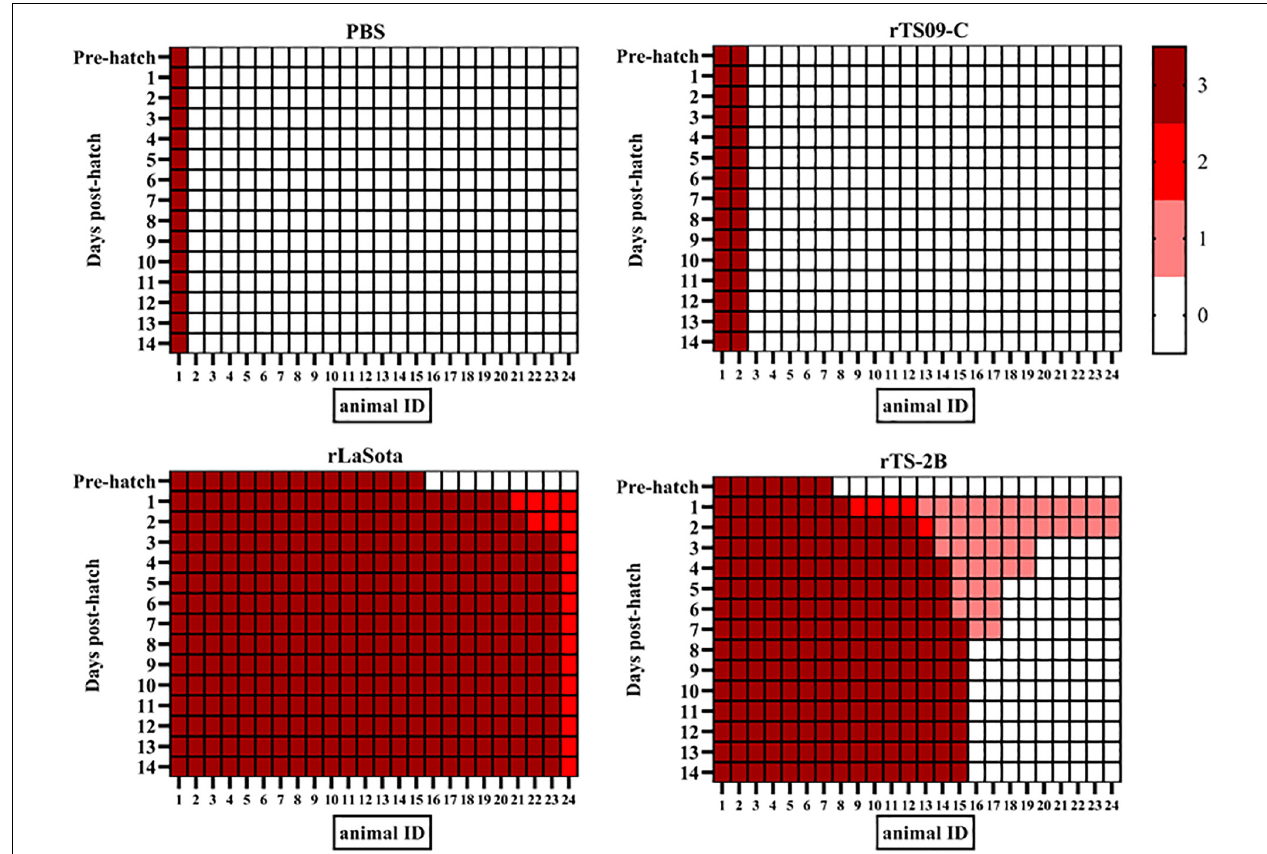
FIGURE 3 | Overview of the clinical features of chickens in ovo vaccinated with NDV. The clinical scores for 24 birds in each group. At each observation point, each bird was scored: normal = 0, slightly sick (reduced food intake or respiratory distress) = 1, severely sick (reduced food intake and respiratory distress) = 2, dead = 3.